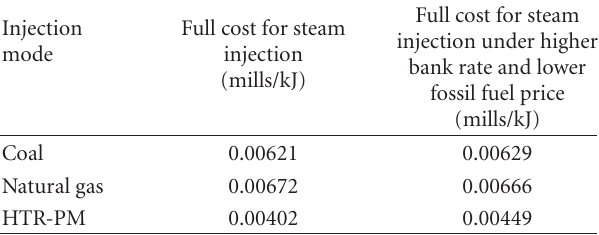
Table 5: Costs of steam injection by considering enthalpy di ff erence of steam.